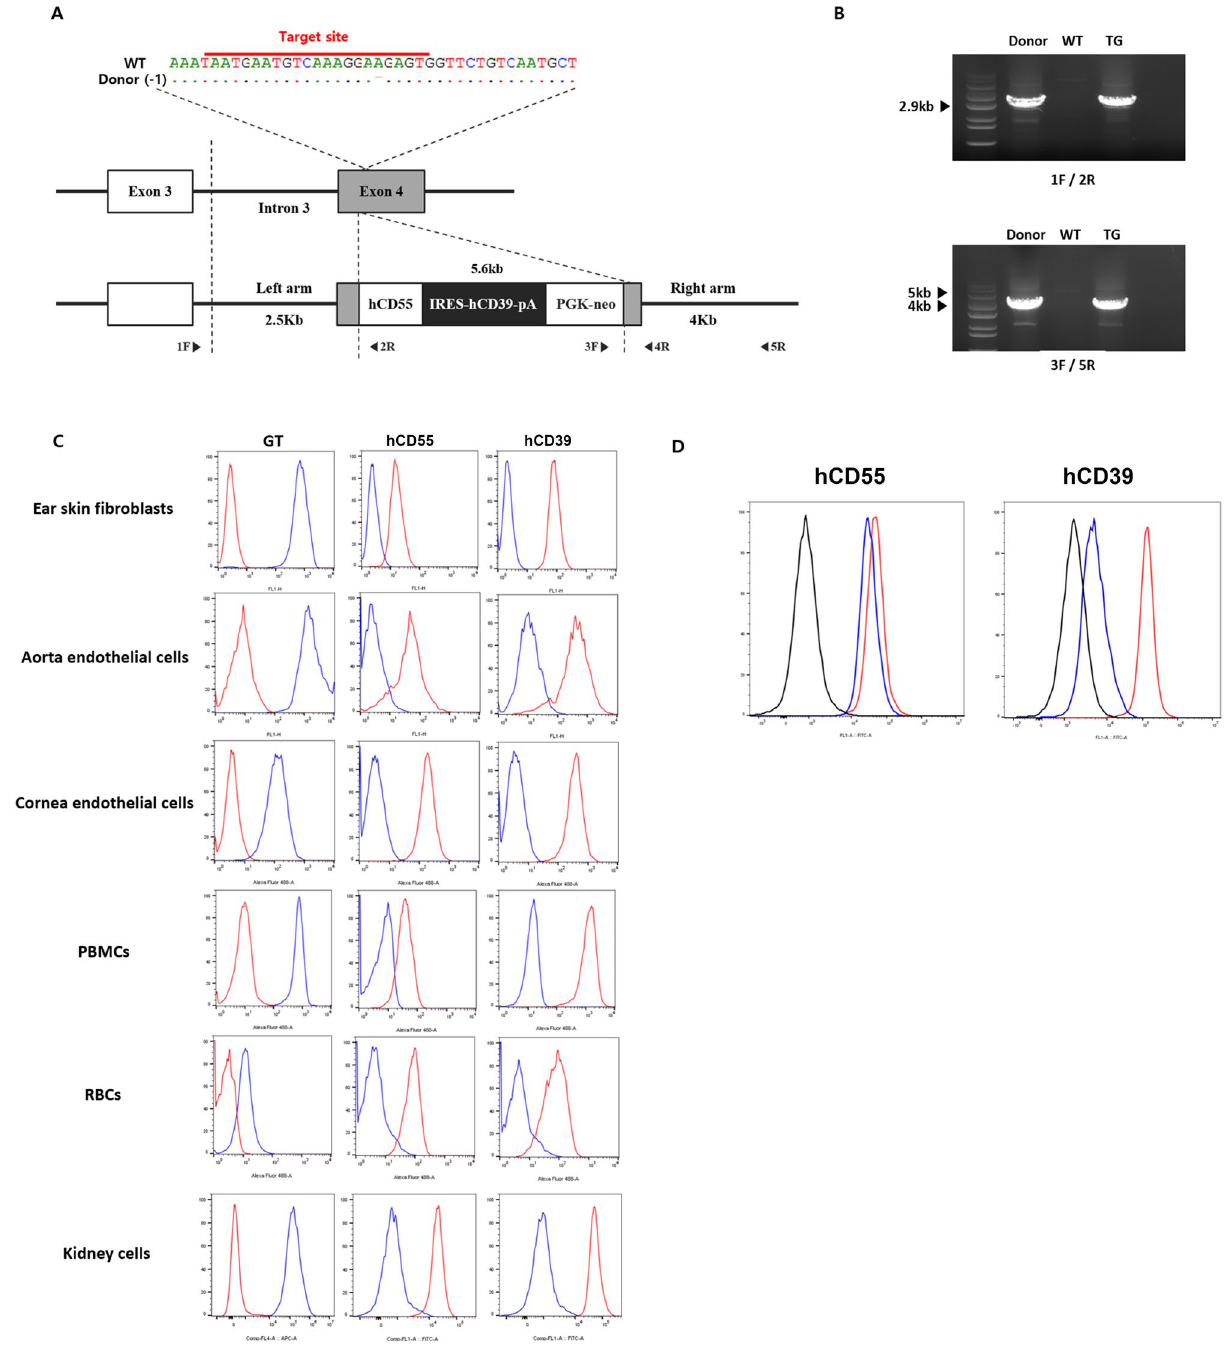
Figure 1. Ablation of GalT and targeted hCD55 and hCD39 gene at GGTA1 locus on produced GTKO/CD55/ CD39 targeted cloned pig. ( A ) Schematic of targeting strategy to ablate GalT and knock-in of hCD55 and hCD39 gene. ( B ) Targeting PCR analysis in GTKO/CD55/CD39 transgenic pig (Donor; targeted colony, WT; wild-type, TG; transgenic pig). ( C ) Cell surface expression of GalT, hCD55, and hCD39 on variety cell source from wild type (blue line) and GTKO/CD55/CD39 transgenic pig (red line). ( D ) Comparison of hCD55 and hCD39 expression on GTKO/CD55/CD39 pig aorta endothelial cells (red line), and human aorta endothelial cells (blue line). Wild-type pig aorta endothelial cells (black line) was used as negative control. The original gels are presented in supplementary Fig.